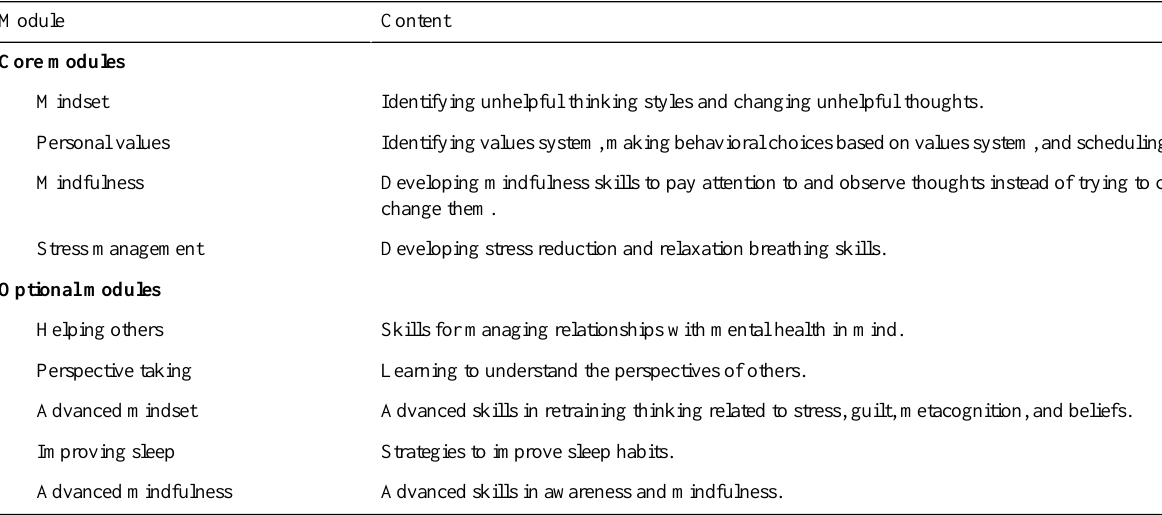
Table 2. Outline of the Uprise module